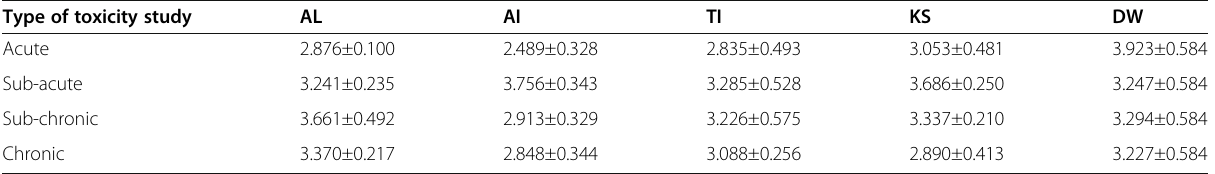
Table 2 Organosomatic index of liver of rats subjected to short, medium and long term oral administration of extracts of four ethnomedicinal plants